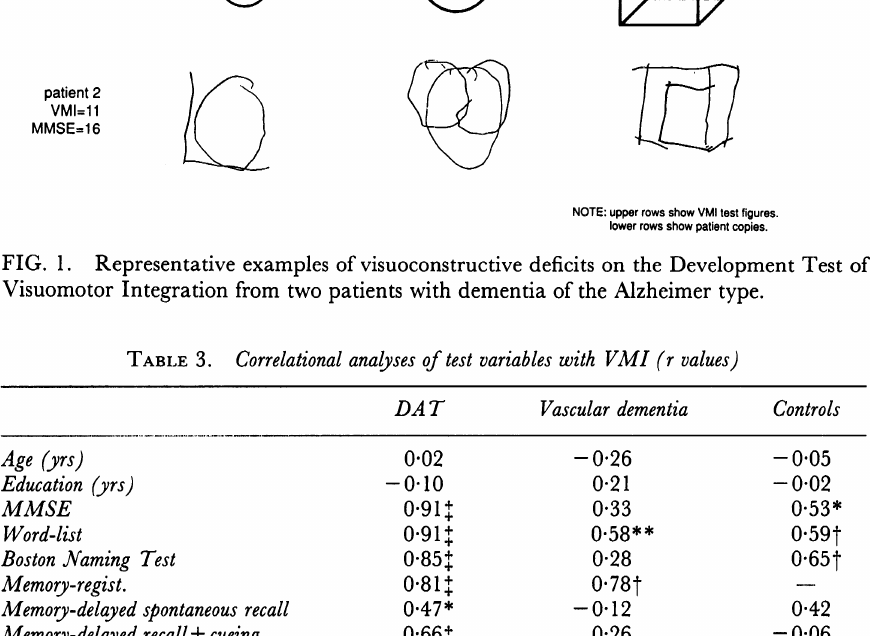
FIG. 1. Representative examples of vi suo constructive deficits on the Development Test of Visuomotor Integration from two patients with dementia of the Alzheimer type.